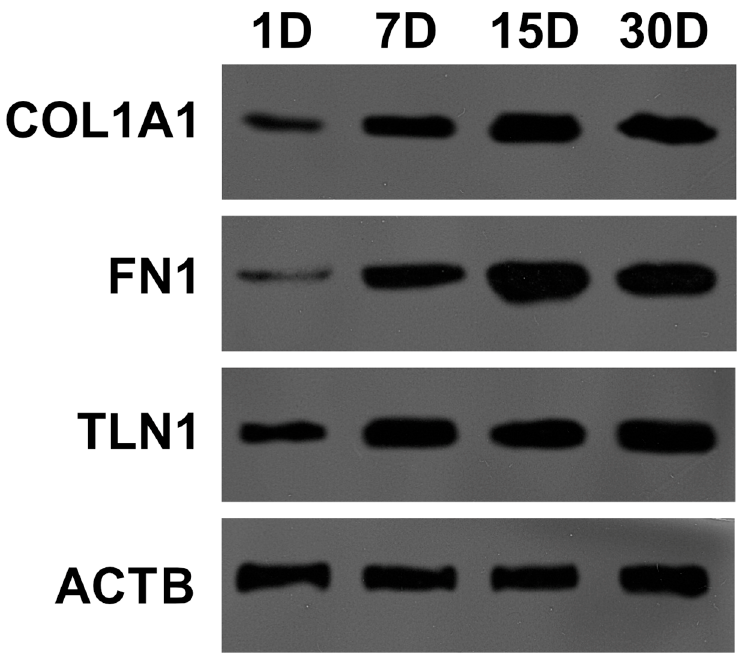
Figure 7. The changes in Collagen Type I Alpha 1 Chain (COL1A1), Fibronectin 1 (FN1), Talin 1 (TLN1), and Actin Beta (ACTB) proteins expression in 24 h, 7, 15, and 30 days of OEC